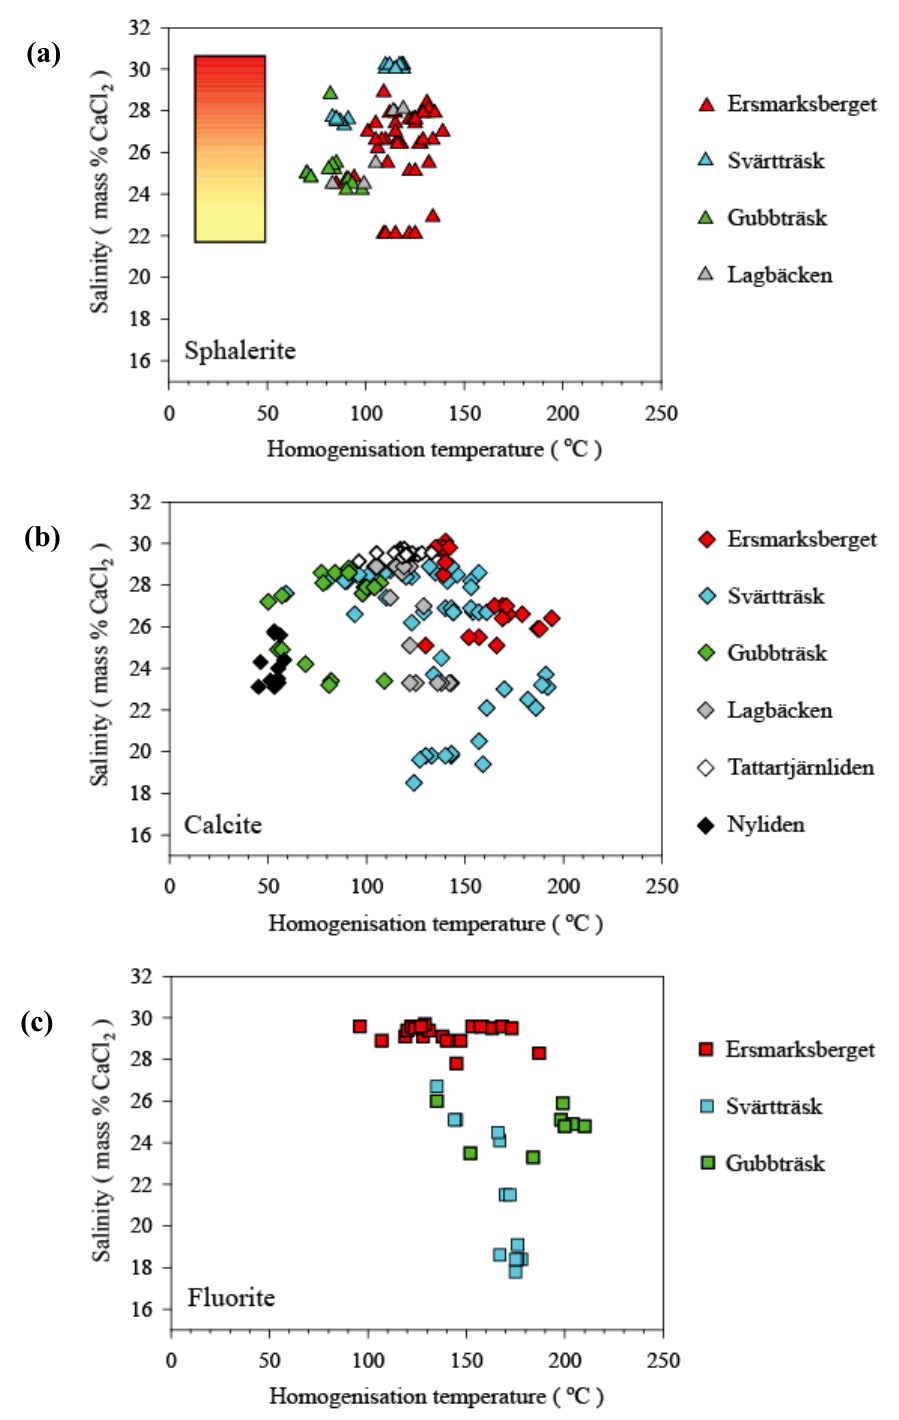
Figure 12. Plots of salinity (eq. mass% CaCl ) versus homogenisation temperature for 2 aqueous fluid inclusions in ( a ) sphalerite, ( b ) calcite and ( c ) fluorite from different Zn-Pb mineralised samples. The inset box in the sphalerite plot symbolizes the colour-zonation in sphalerite and the decreasing salinity in fluid inclusions hosted by red to yellow